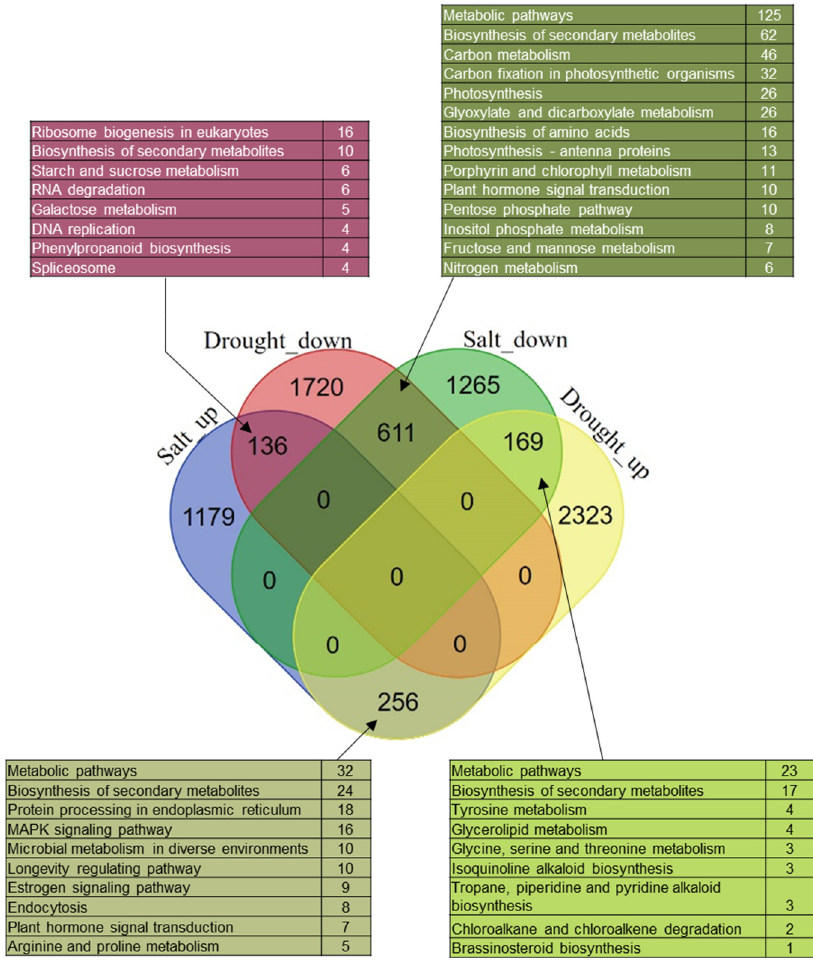
Figure 8. Commonly and reversely regulated genes by salinity and drought stresses in garlic leaves. Differentially expressed genes (DEGs) identified upon exposure to salinity and drought stresses were analyzed using a Venn diagram (http://bioinformatics.psb.ugent.be/webtools/Venn/). The Kyoto Encyclopedia of Genes and Genomes pathways that DEGs were assigned to are shown in tables.